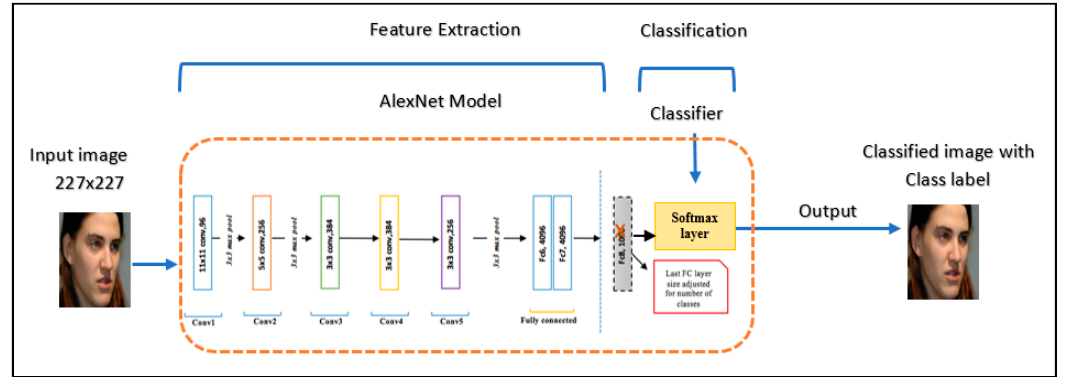
Figure 9. Transfer learning from AlexNet convolutional neural networks.